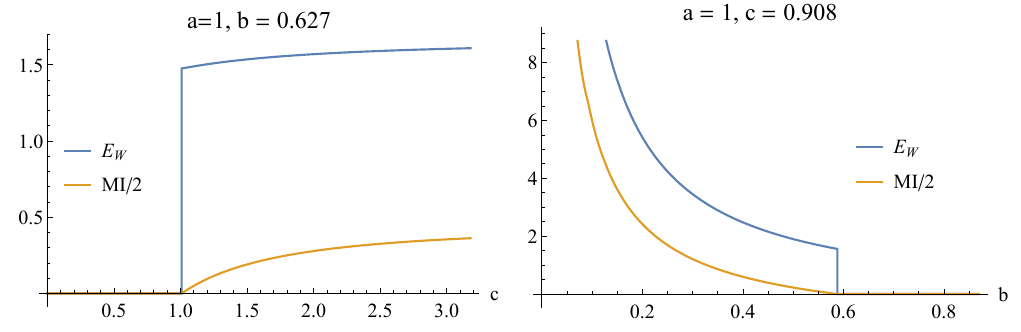
Figure 7 . Left plot: EoP and MI / 2 along c at ( a, b ) = (1 , 0 . 627). Right plot: EoP and MI / 2 along b at ( a, c ) = (1 , 0 .